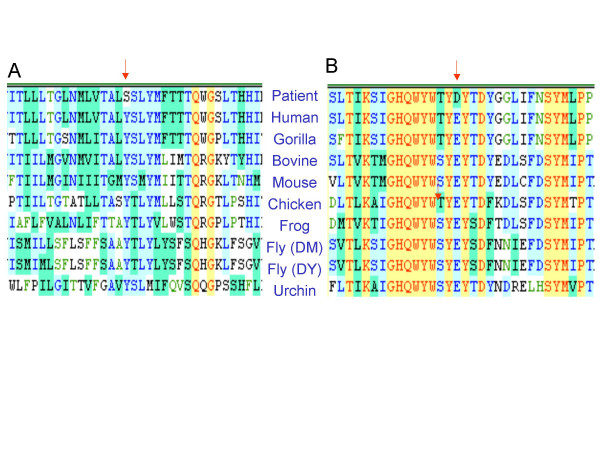
Alignment of novel germline missense mutations A: Case E02, A11976C (Y406S in ND4) and B: Case E16, G7921C (E109D in COII)